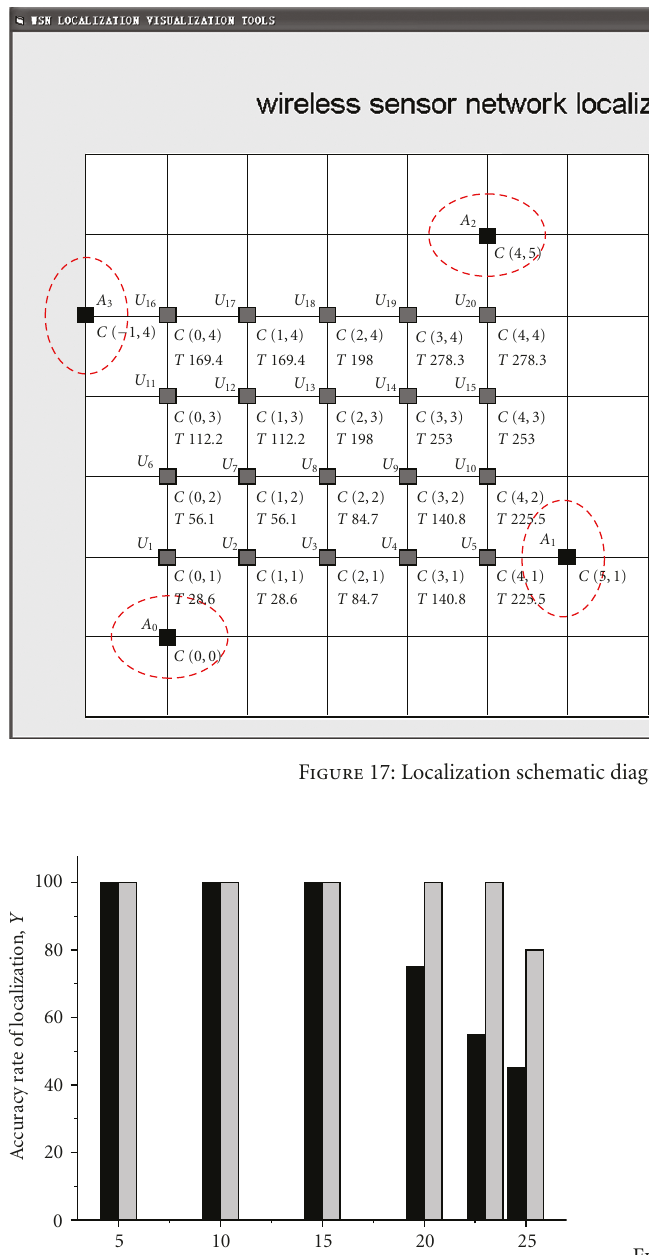
Figure 19: Experimental deployment for Kcdlocation in a